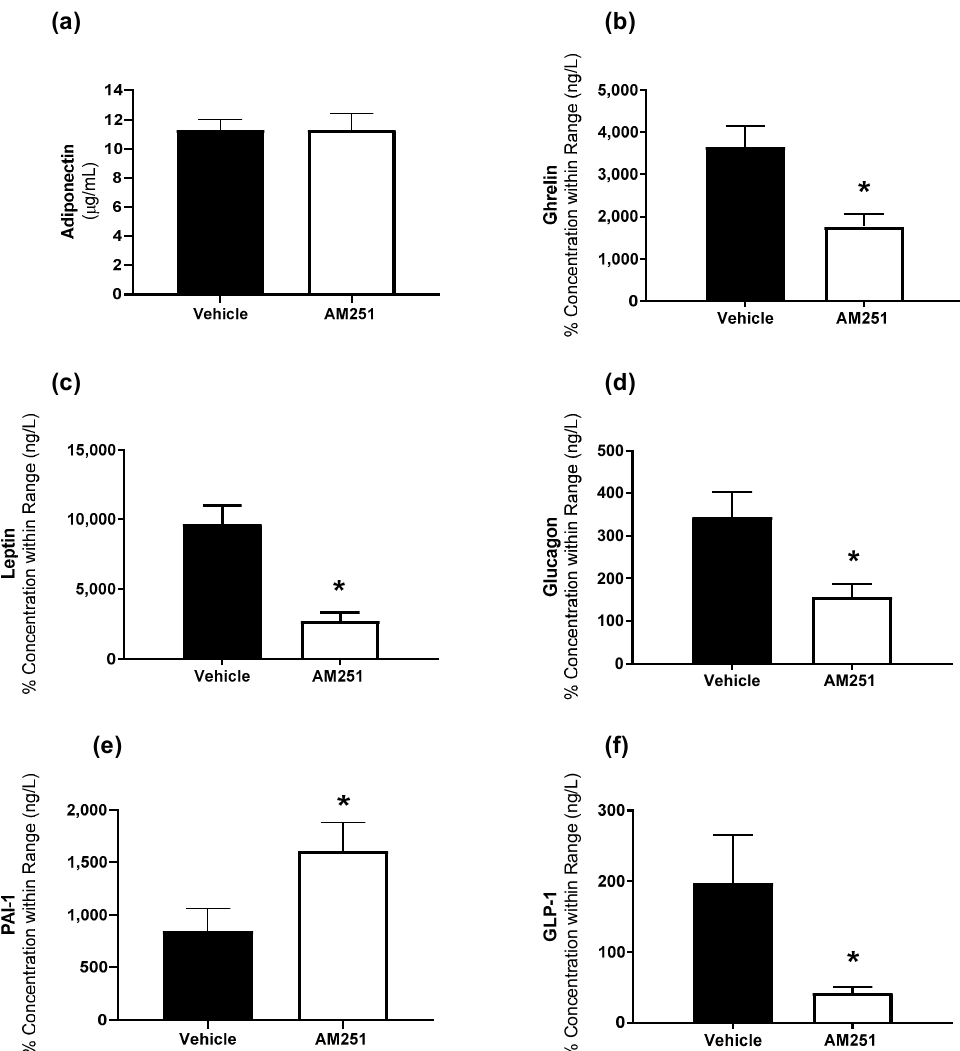
Figure 1. The effect of AM251 treatment on hormones involved in energy homeostasis. HFD rats were injected daily with either AM251 (3 mg/kg of body weight, ip) or vehicle for six weeks. Plasma levels of ( a ) adiponectin, ( b ) ghrelin, ( c ) leptin, ( d ) glucagon, ( e ) PAI- 1 and ( f ) GLP-1. All results are presented as a mean ± SEM from n = 9 (AM251) and n = 5–9 (vehicle) treated rats on an HFD. Significance * p ≤ 0.05 compared to vehicle.